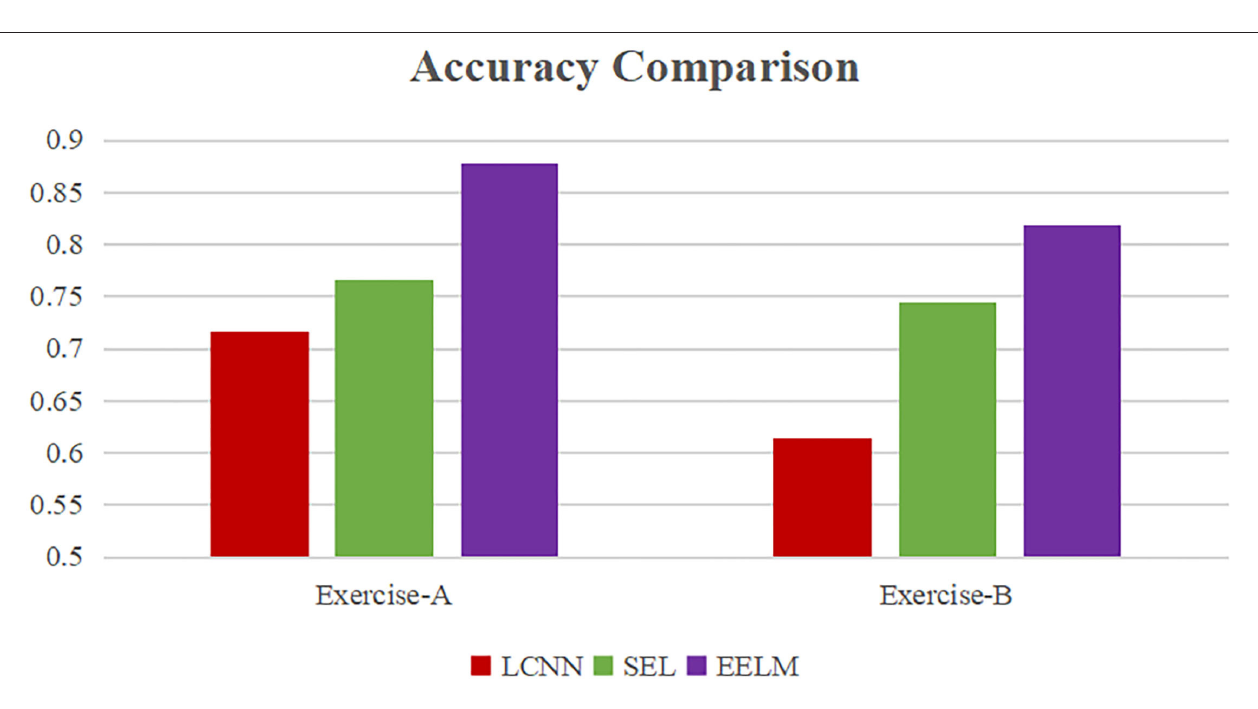
FIGURE 12 | Performance comparison with other existing